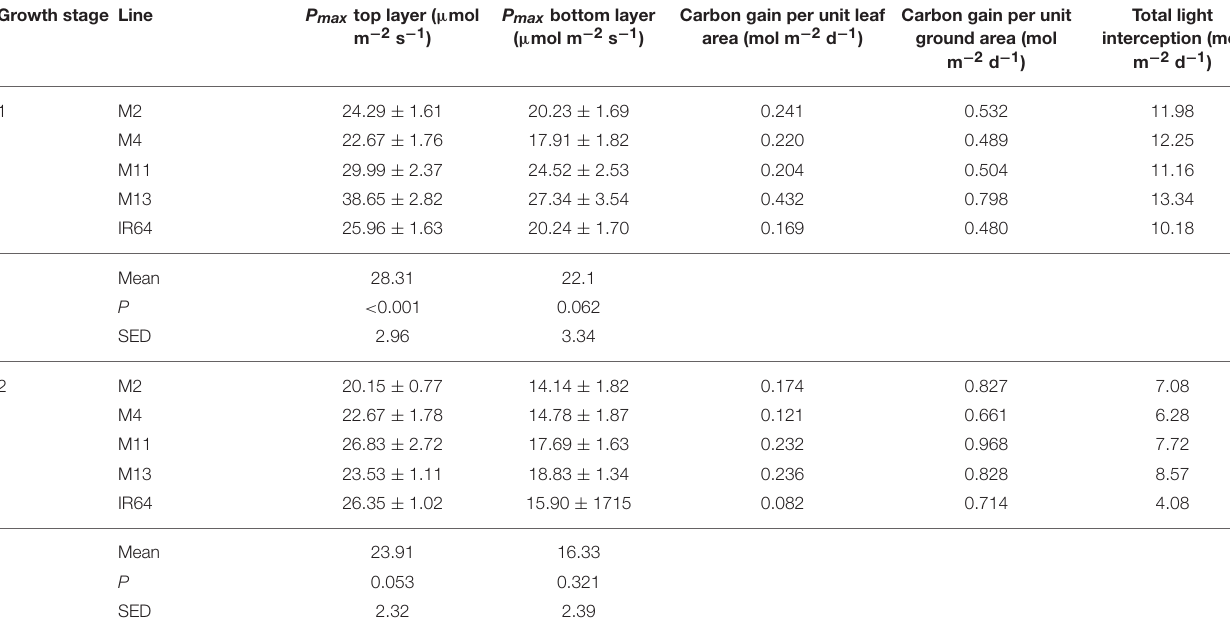
TABLE 6 | Gas exchange and modeling results at each growth stage. Growth stage